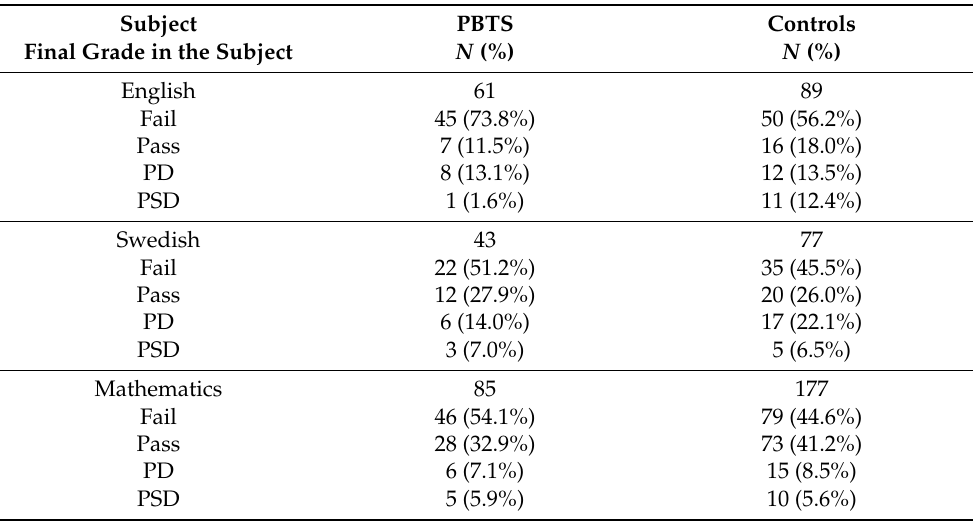
Table 6. Information on the number and percentage of the final grades fail, pass, pass with distinction (PD) and pass with special distinction (PSD) in the school subjects English, Swedish and mathematics of the PBTS and controls with missing information on all three national test subtests or in the